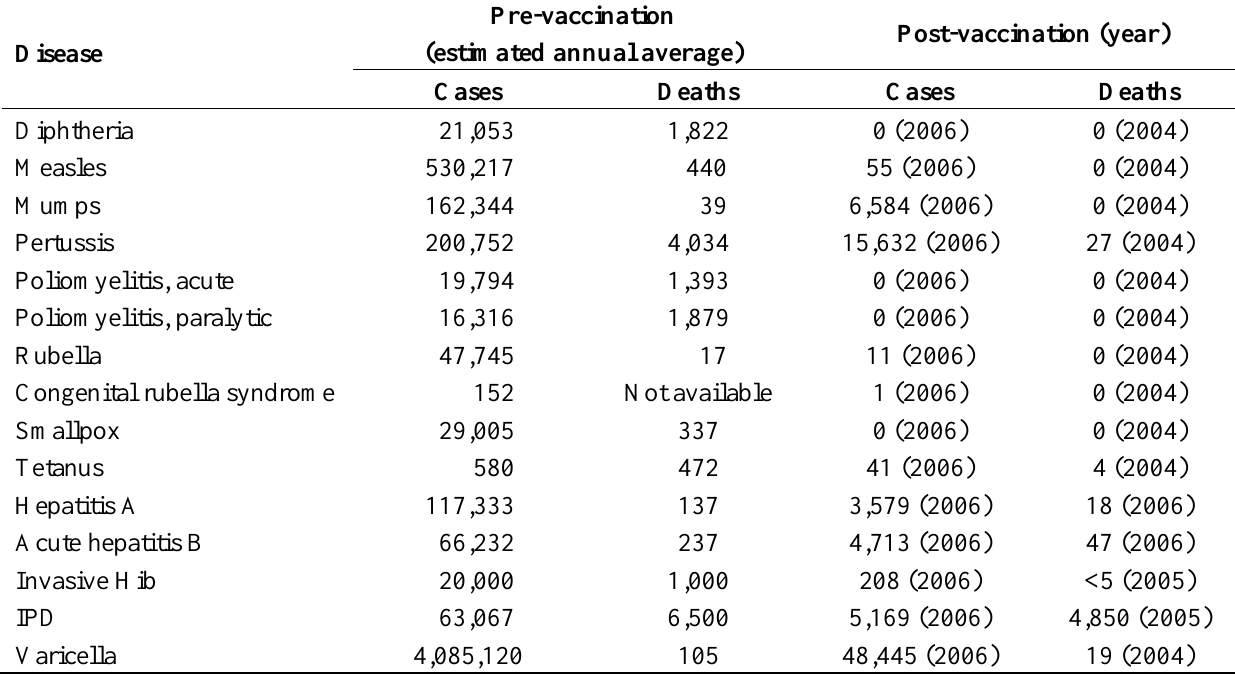
Table 1. Impact of vaccines in the USA in terms of numbers of reported cases and deaths associated with disease before and after the introduction of vaccination (reprinted and adapted from Bonanni and Santos 2011 [7] and Roush and Murphy 2007